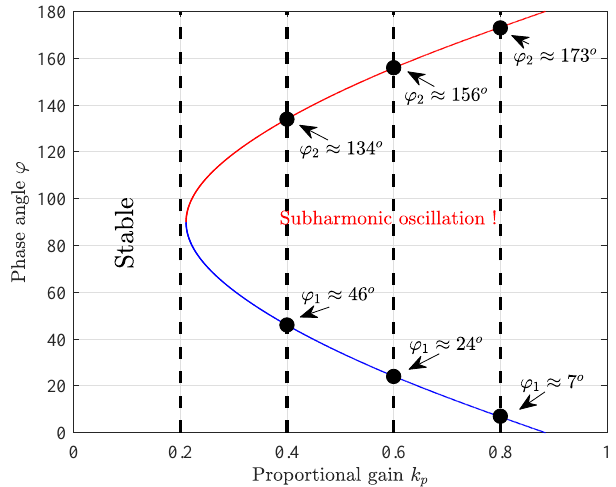
Figure 9. Critical phase angles in [ ◦ ] defining the SO interval in terms of the proportional gain k p